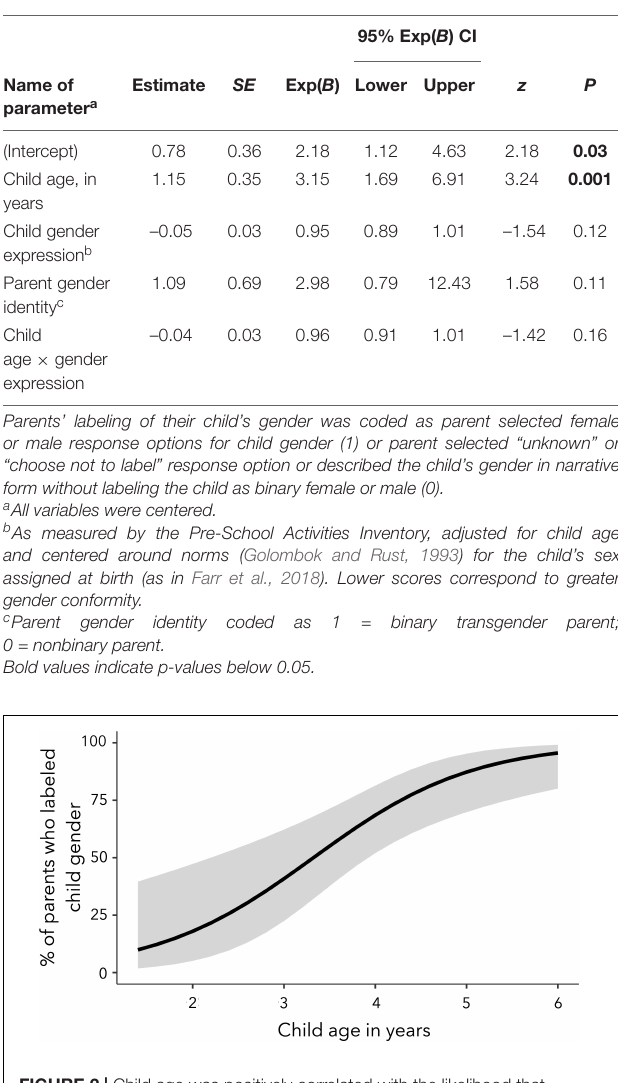
TABLE 2 | Final logistic regression model predicting nonbinary and binary transgender parents’ likelihood of labeling their child’s gender identity.